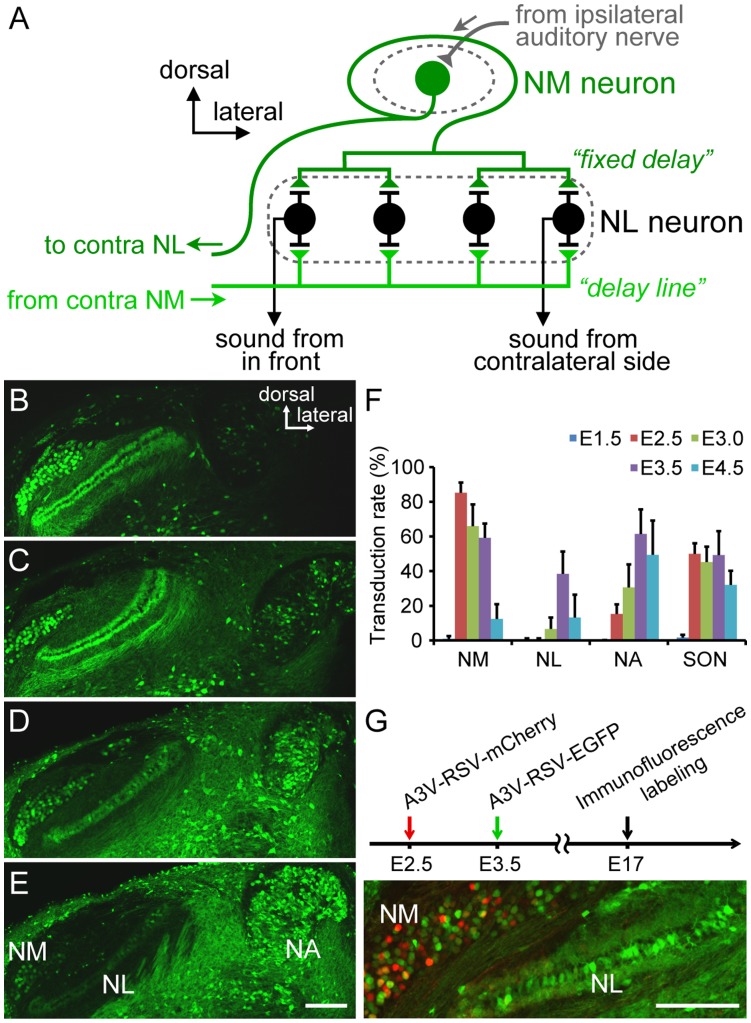
A3V-mediated gene transfer into the embryonic chick auditory brainstem.(A) Schematic of a primary ITD detection circuit composed of NM and NL neurons. The ipsilateral NM axons provide a simultaneous input to the dorsal side of the NL neurons, whereas the longer delay lines of contralateral NM axons project to the ventral side of more lateral NL neurons. Because NL neurons function as a coincident detector of binaural synaptic inputs, NL neurons in more lateral positions respond maximally to sounds originating in far contralateral space. (B–E) A3V-RSV-EGFP (0.5–1.5 µl, 1×1012 GC/ml) was injected into the neural tube at E2.5 (B), E3.0 (C), E3.5 (D), and E4.5(E), and EGFP signal at E17 was analyzed by immunofluorescence labeling of coronal sections. Scale bar indicates 200 µm. (F) A3V transduction rates in the embryonic auditory nuclei were quantified as the percentage of EGFP-expressing cells within total NeuN-positive cells in each nucleus (n = 6). The raw data are listed in Table S5. (G) A3V-RSV-mCherry and A3V-RSV-EGFP (0.5–1.5 µl, 1×1012 GC each) were injected at E2.5 and at E3.5, respectively. Spatial pattern of A3V transduction at E17 was analyzed by double immunofluorescence labeling for EGFP (green) and mCherry (red). Scale bars indicate 200 µm.